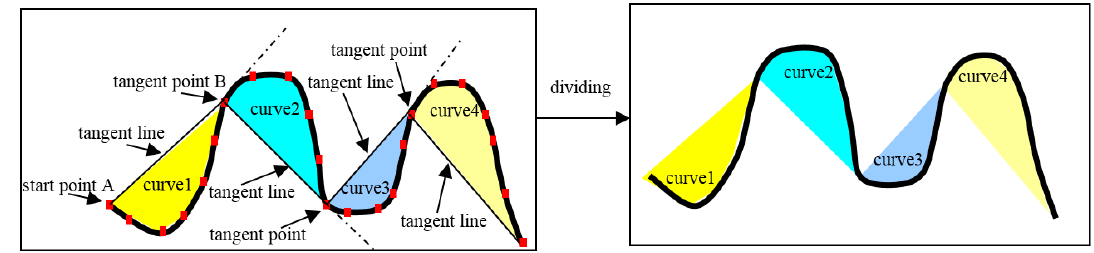
Figure 3. Principle of using ODC method to divide a cartographic line into curves.